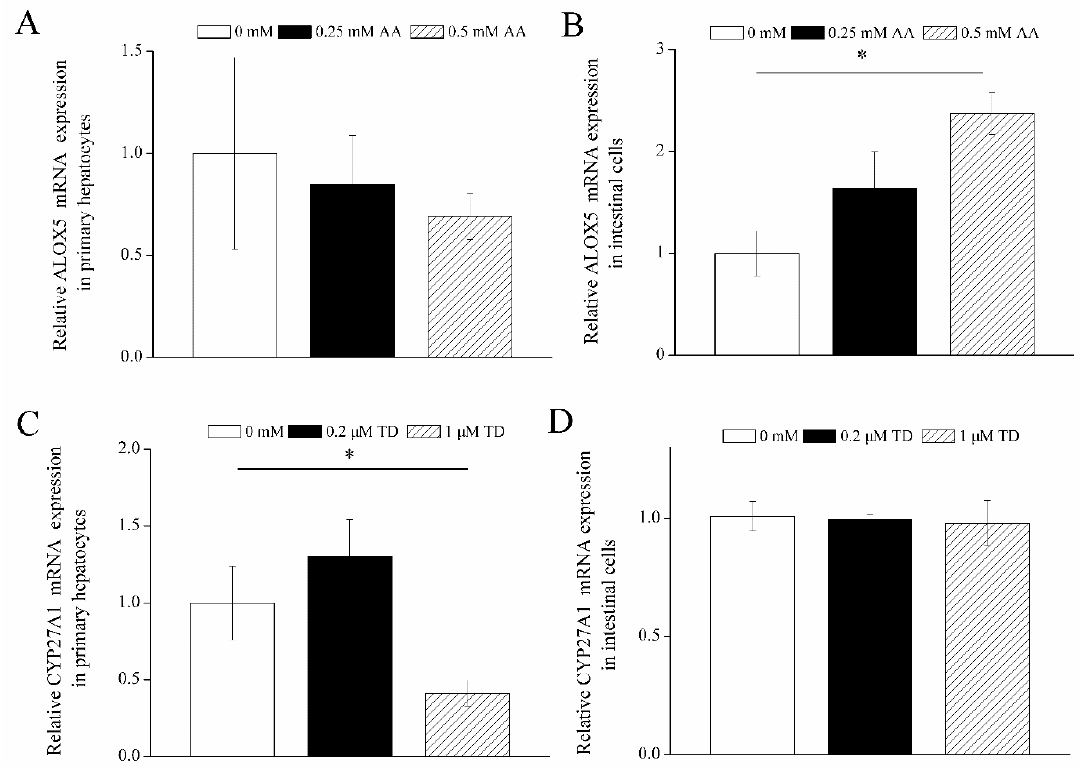
Figure 4. The effects of arachidonic acid ( A , B ) and tetrahydrocorticosterone ( C , D ) on the relative mRNA expression of arachidonate 5-lipoxygenase ( ALOX5 ) or cytochrome P-450 27A1 ( CYP27A1 ) in the primary hepatocytes and intestinal cells of goose. Primary hepatocytes and intestinal cells were isolated from goose embryos after 23 days of incubation. ARA = arachidonic acid. TD = tetrahydrocorticosterone. For ARA treatment, hepatocytes and intestinal cells that were treated with complete culture media were considered as the control group. For TD treatment, cells which were treated with complete culture media containing 2% bovine serum albumin and 0.2% alcohol were taken as the control. * p < 0.05. All data are presented as means ± SEM ( n = 6).